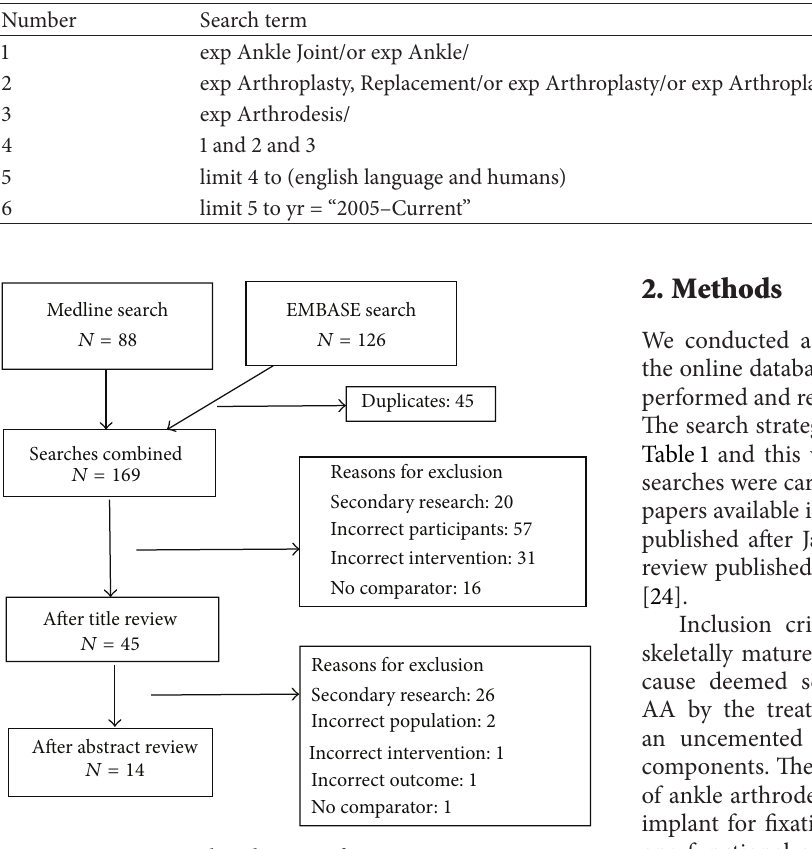
Figure 1: Flow diagram of review